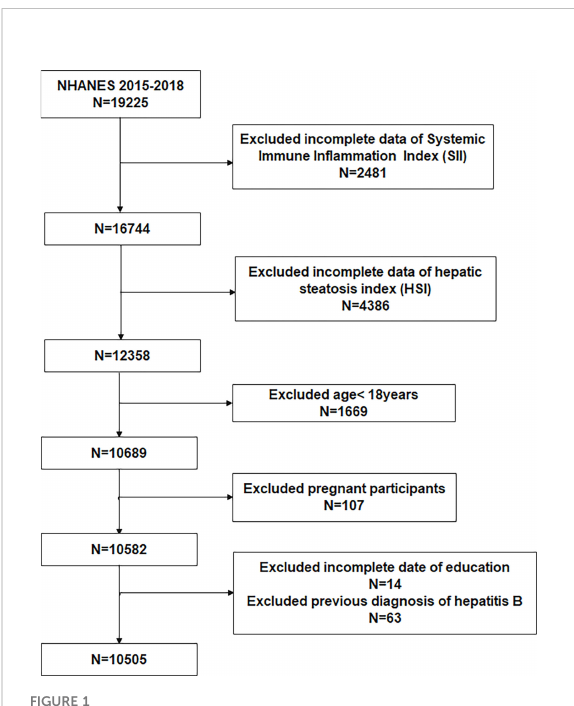
FIGURE 1 Flowchart of the participants selection from NHANES 2015 –